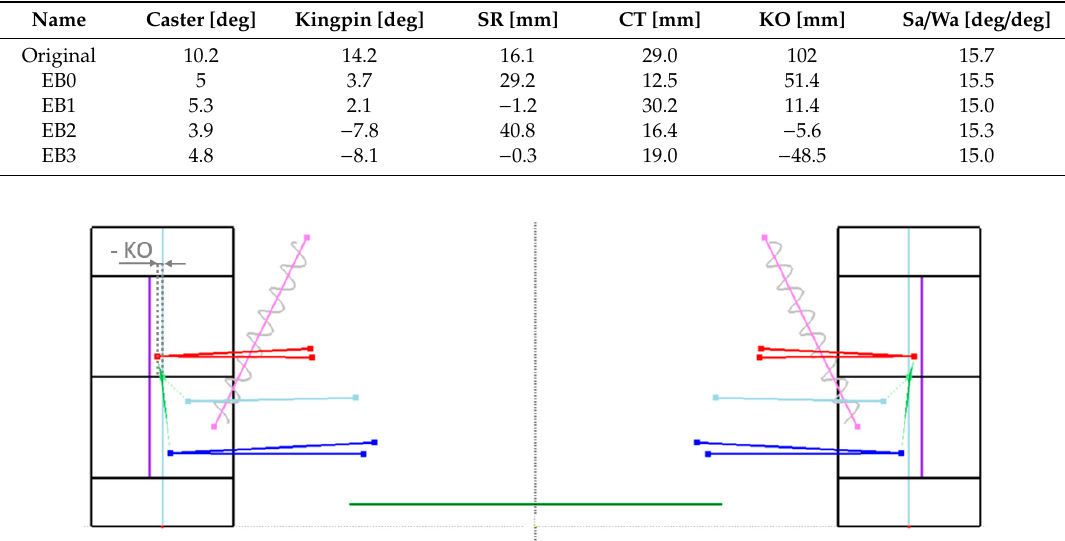
Table 3. New EB2 and EB3 suspensions compared with the previous ones.